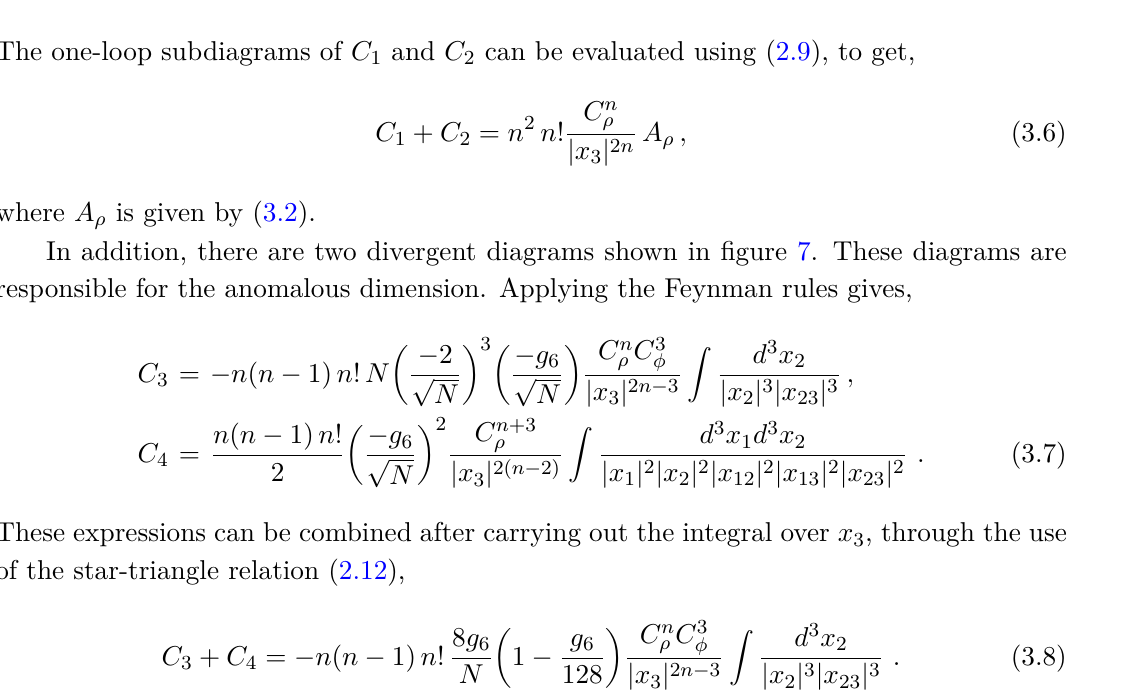
Figure 7 . Divergent diagrams which contribute to the full correlator The black squares denote insertions of the composite operator ρ n